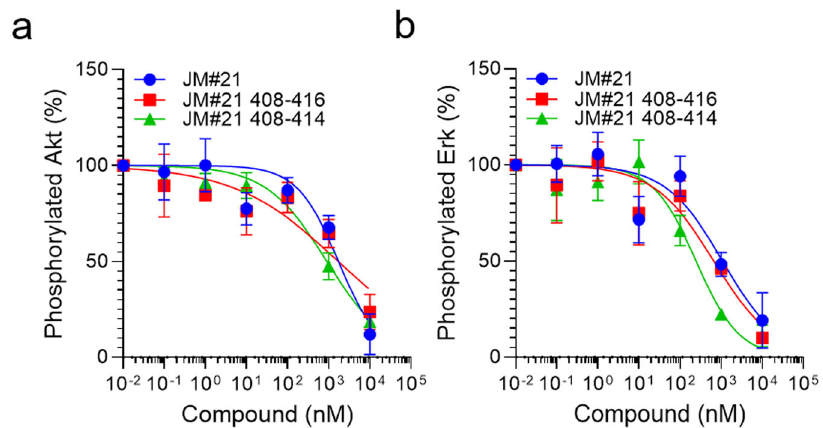
Fig. 6 Truncated JM#21 variants dose-dependently inhibit CXCL12-mediated signaling. SupT1 cells were stimulated with 100 ng/ml CXCL12 in the presence of peptides for 2 min. Afterward, the reaction was stopped by adding 2% PFA and shifting the cells to 4 °C. Cells were then permeabilized and subsequently stained with antibodies against pAkt ( a ) and pErk ( b ) for analysis in fl ow cytometry. Shown are data derived from three individual experiments ± SEM.